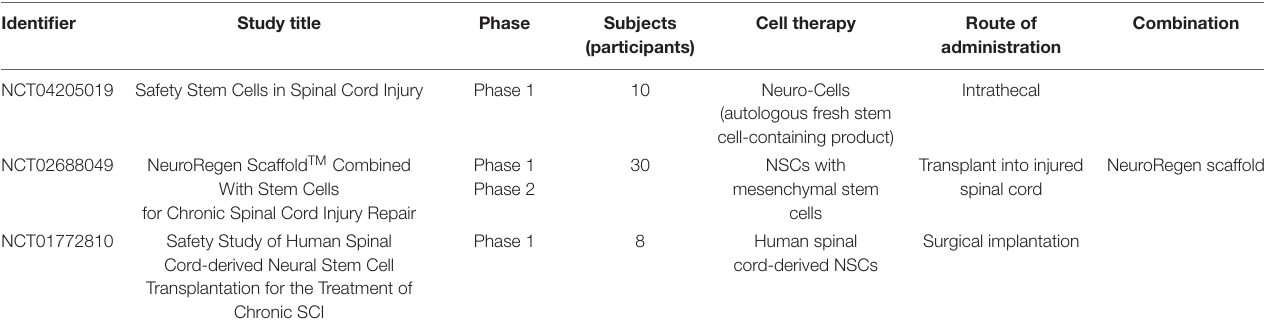
TABLE 6 | Ongoing clinical trials currently targeting chronic SCI utilizing NSC/NPCs